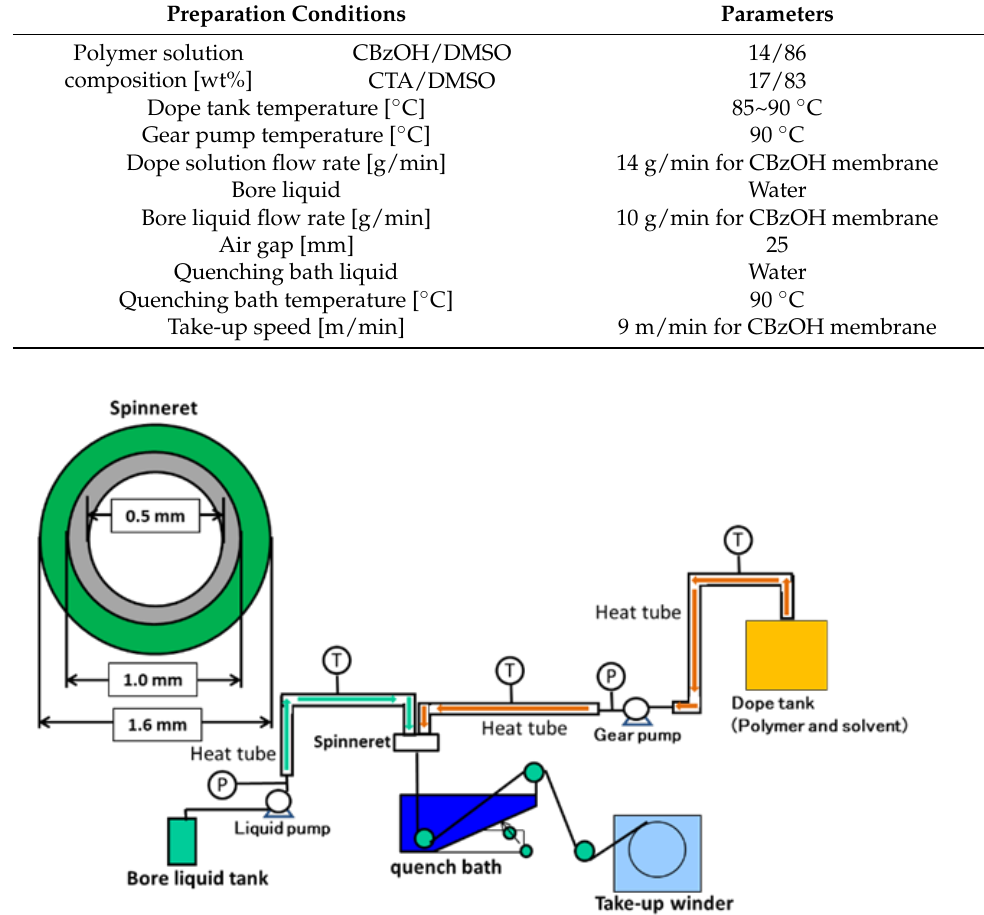
Table A5. Preparation conditions of hollow fiber membranes by NIPS method.